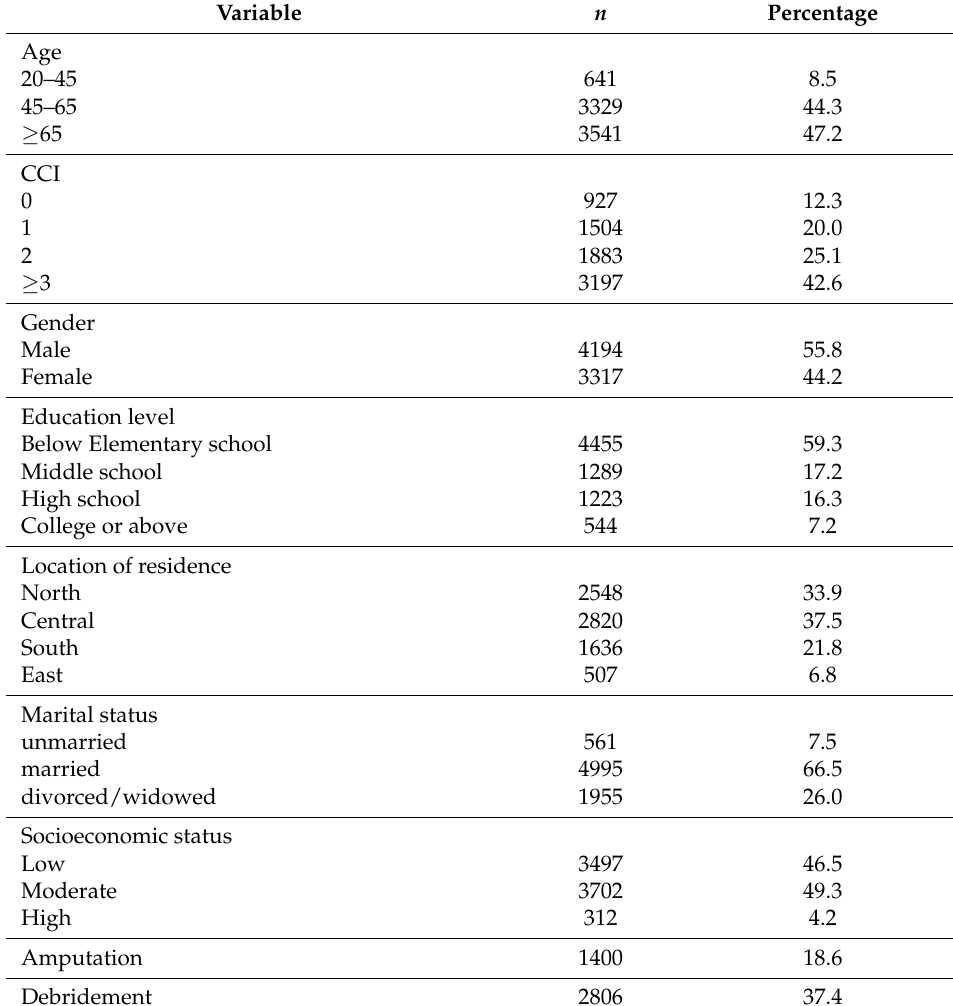
Table 1. Characteristics of diabetic foot ulcer (DFU) patients ( N = 7511). Variable